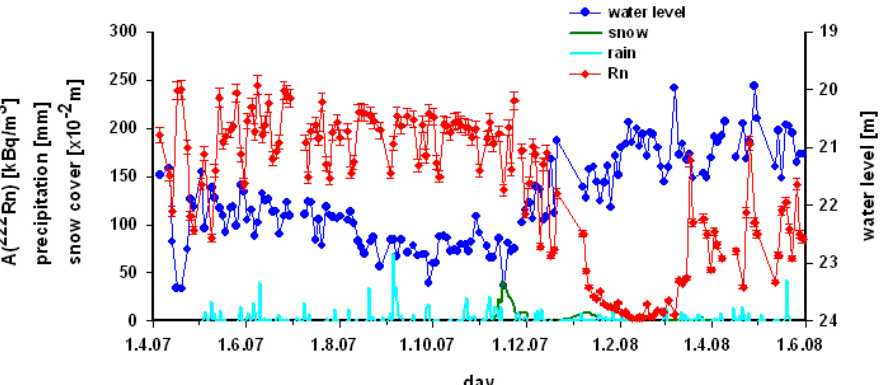
Fig. 4. Seasonal change of radon activity concentration and water level in HG-8 borehole. Vertical bars represent the standard deviation of the radon activity concentration